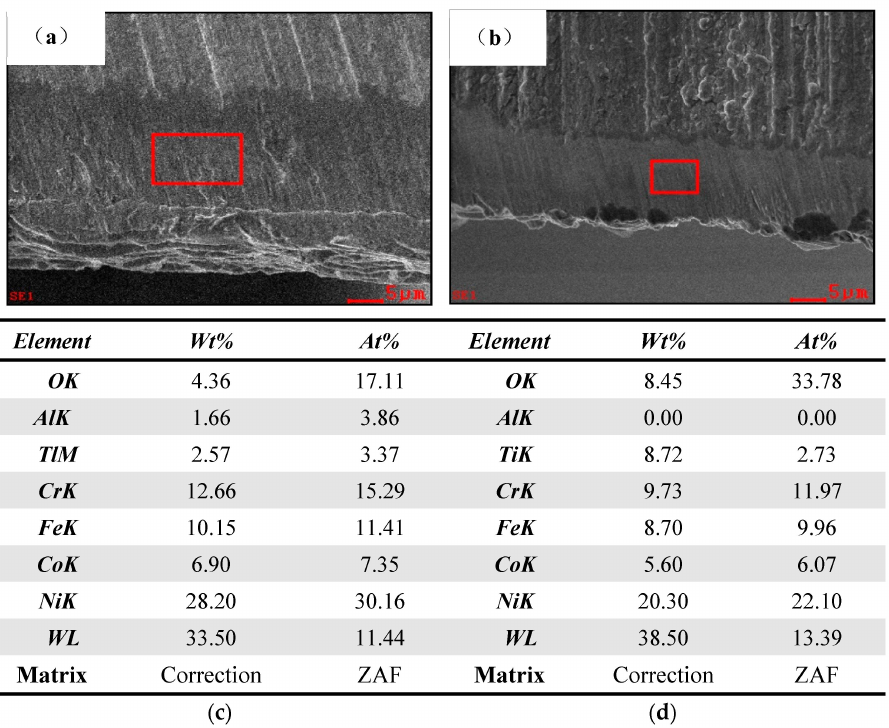
Figure 11. Energy spectrum analysis of the wear zone of drill rear drill surface. ( a ) Main rear tool surface of the uncoated bit. ( b ) Main rear tool surface of the CrAlYN coated bit ( c ) Element composition list of uncoated bit rear tool face. ( d ) Element composition list of coated bit rear tool